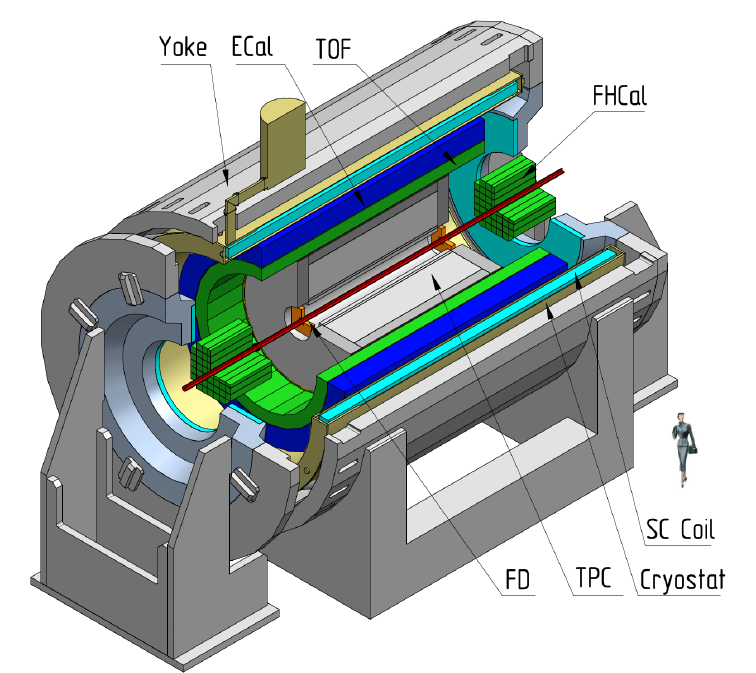
Figure 1. Schematic view of the first stage of the MPD